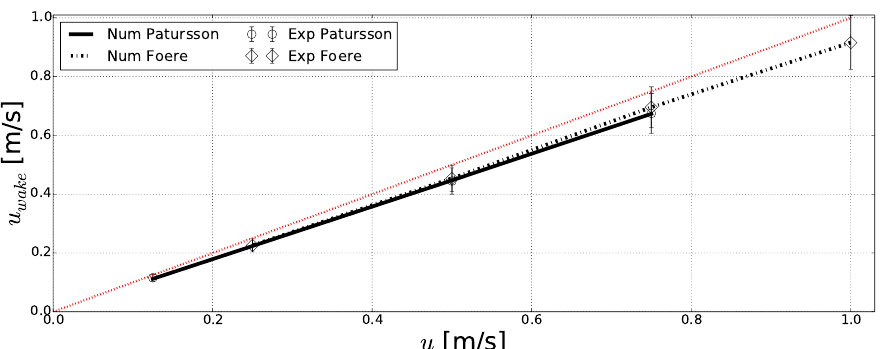
Figure 3. Comparison of the numerically predicted and measured flow velocity behind the net as a function of the inflow velocity u . All net panels are placed perpendicular to the inflow. The references are taken from [7,24]. The red line indicates results if no net would be present. The bars indicate a 10% error